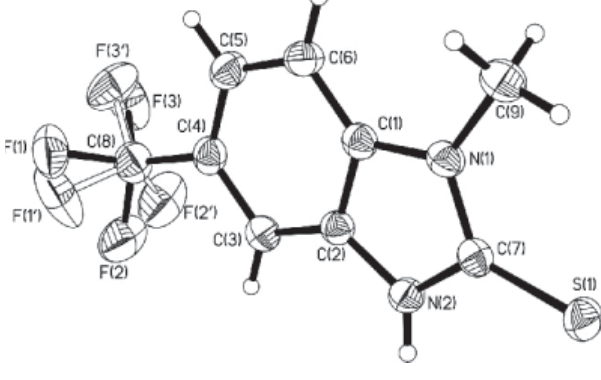
dihedral angle 1.27(0.16) (cid:1) . In the the title structure the three fluo- rine atoms of trifluoromethyl exhibt disorder status with occu- pancy ratio of 0.6:0.4. Each pair of two neighbouring molecules